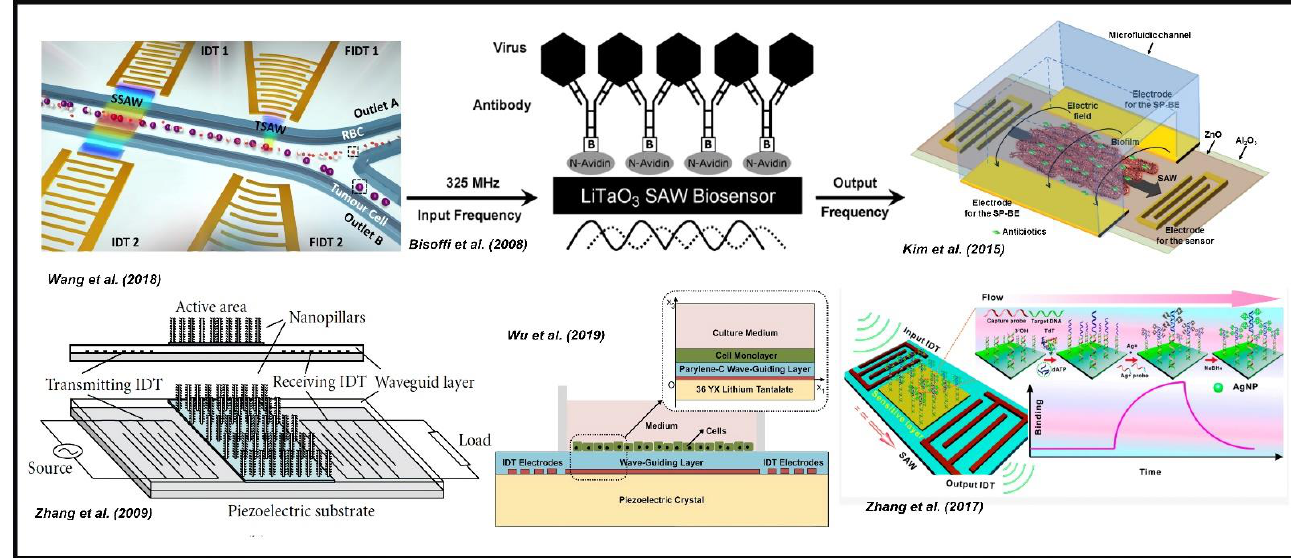
Figure 19. Using a similar philosophy, different applications of Love-wave based SAW sensing where input frequencies and output frequencies are compared to detect the change in the bio-func- tionalized layer [171–176]. layer